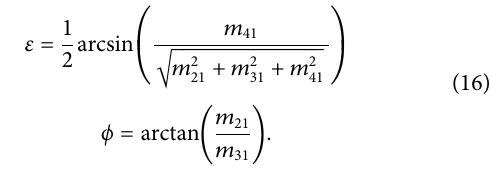
Frontiers in Physics |